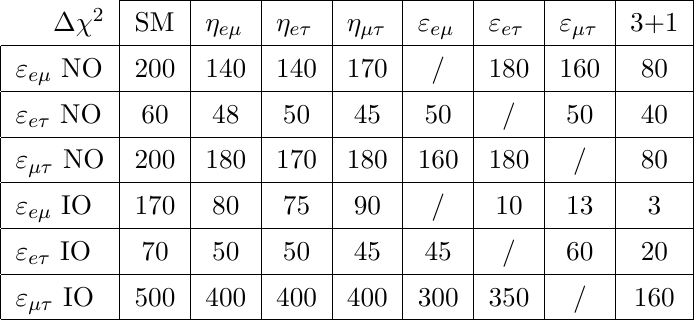
Table 3 . ∆ χ 2 obtained fitting to each case all the models taken into account using as true values the best fits of the vector NSI case.